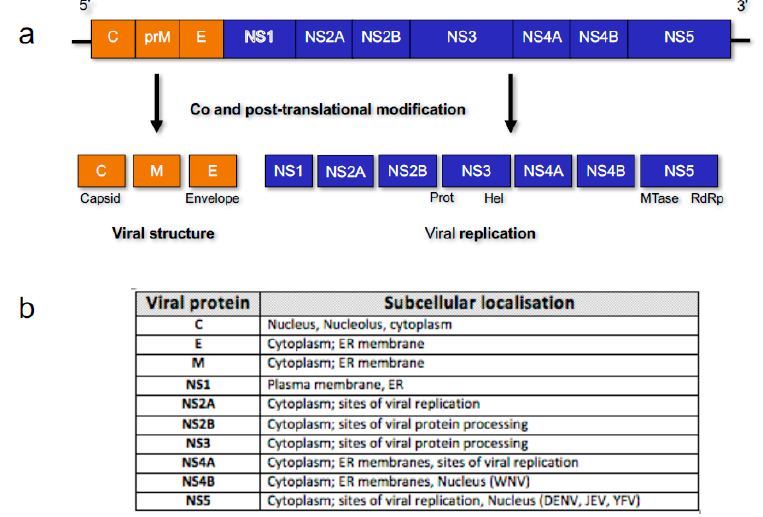
Figure 1. Representation of Flavivirus genome organisation. ( a ) Ten viral genes encode for three structural and seven non-structural (NS) viral proteins that are co- and post-translationally modified into mature viral proteins by host factors and the viral NS2B-3 protease complex [2]; ( b ) Viral protein subcellular localisation is generally cytoplasmic or associated with the endoplasmic reticulum (ER) membrane, due to the localisation of replication, but in specific viruses (listed), proteins such as NS5 can also localise to the nucleus.